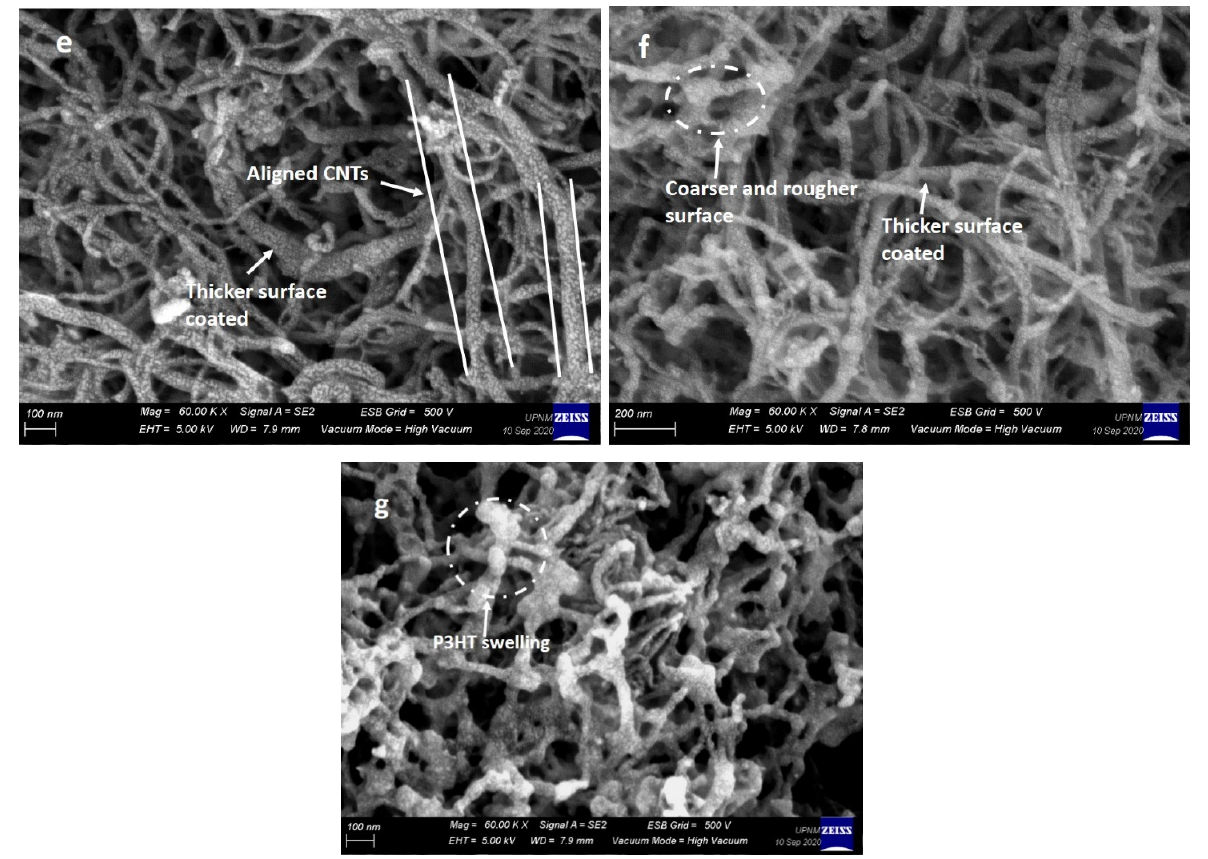
Figure 4. FESEM image of ( a ) pristine P3HT, ( b ) pristine MWCNT-OH, P3HT/MWCNT-OH nanocomposites at different reaction times ( c ) 24 h, ( d ) 48 h, ( e ) 72 h, ( f ) 96 h, and ( g ) 120 h.